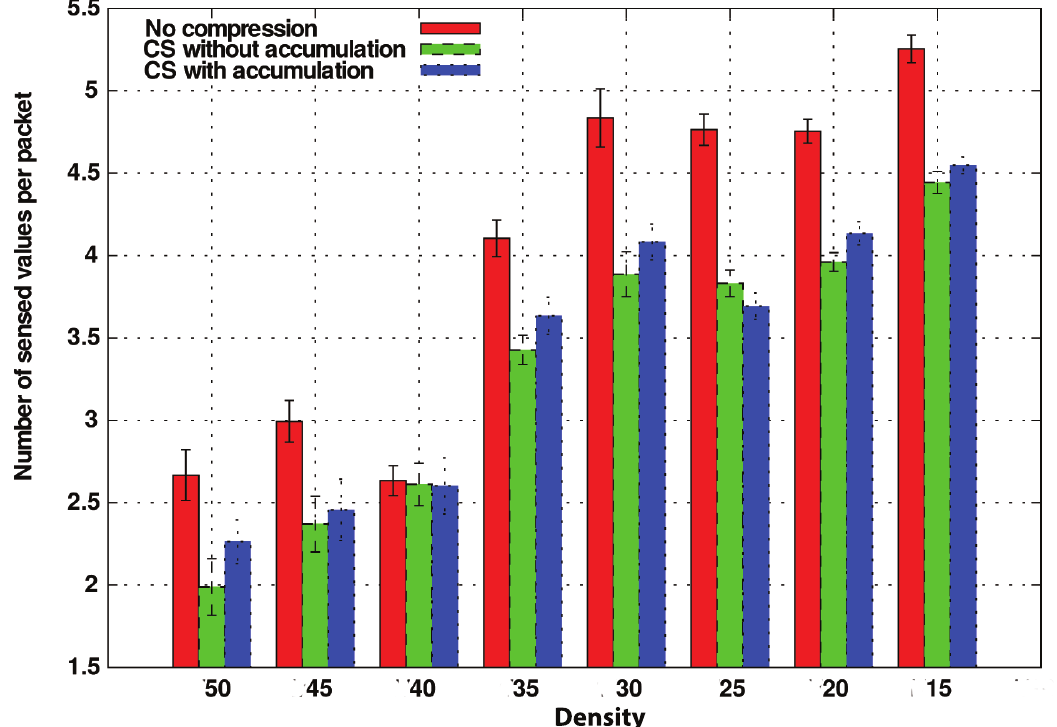
Figure 12. Number of sensed measurements carried in packets for CSAccum and CSPure for maximum time (TMAX) = 20 s. Density in x-axis corresponds to the name given to that density in Table